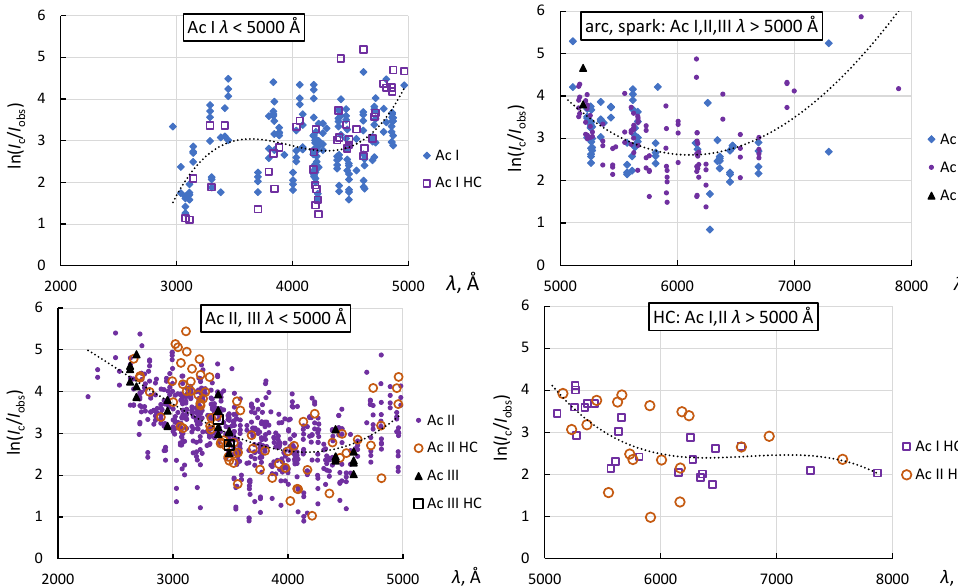
Figure 6. Inverse logarithmic spectral response functions for observations of Meggers et al. [9]. Top left: Observed Ac I short-wavelength line intensities in the Ag and Cu arc and spark spectra (labeled “Ac I”) and in the HC spectrum (labeled “Ac I HC”). Bottom left: Observed Ac II and Ac III short-wavelength line intensities in the Ag and Cu arc and spark spectra (labeled “Ac II” and “Ac III”) and in the HC spectrum (labeled “Ac II HC” and “Ac III HC”). Top right: Observed Ac I, Ac II, and Ac III long-wavelength line intensities in the Ag and Cu arc and spark spectra (labeled “Ac I”, “Ac II”, and ”Ac III”). Bottom right: Observed Ac I and Ac II long-wavelength line intensities in the HC